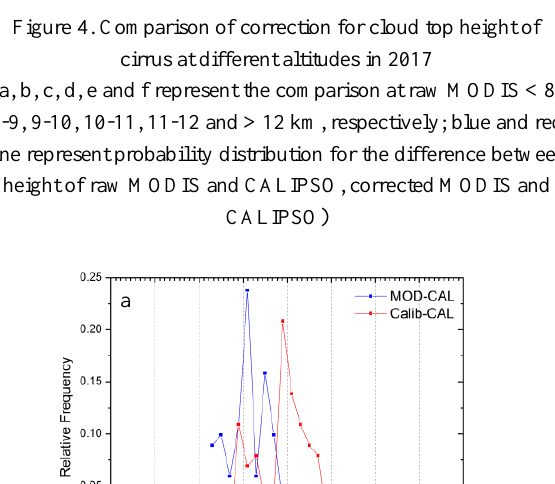
Figure 6a is the image of annual mean MODIS cloud top height before correction. Figure 6b is the annual mean cloud top height after correction. Figure 6c is the difference between before and after correction. Higher cloud top height areas are found in central Hebei, Bohai Bay and eastern Shandong Peninsula, corresponding to smaller correction